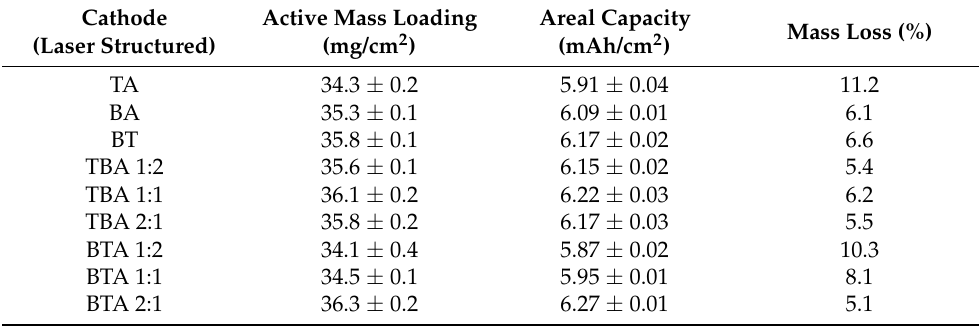
Table 2. Active mass loading, areal capacity, and mass loss of laser-structured thick-film cathodes in comparison to unstructured